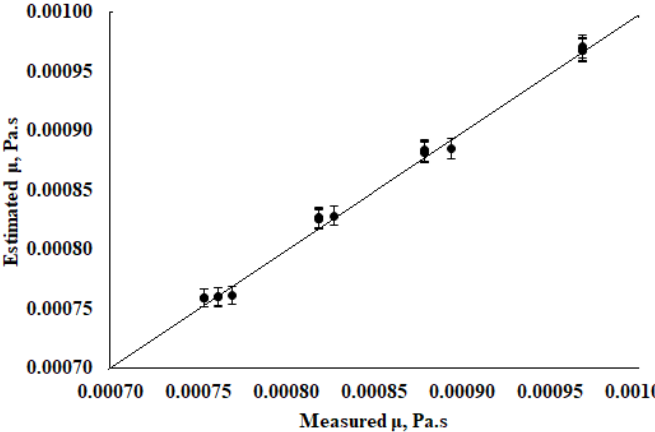
Figure 8. Estimated and measured effective viscosity, (Pa.s) of hybrid nanofluid. Empirical relations for density and specific heat of hybrid nanofluid are [43]: